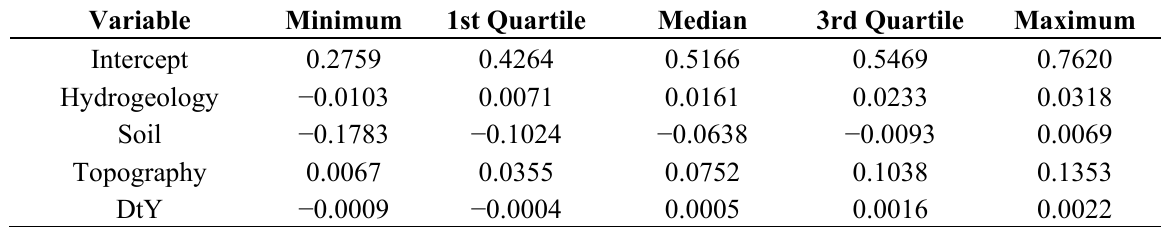
Table 4. The parameter estimates of the GWR model.